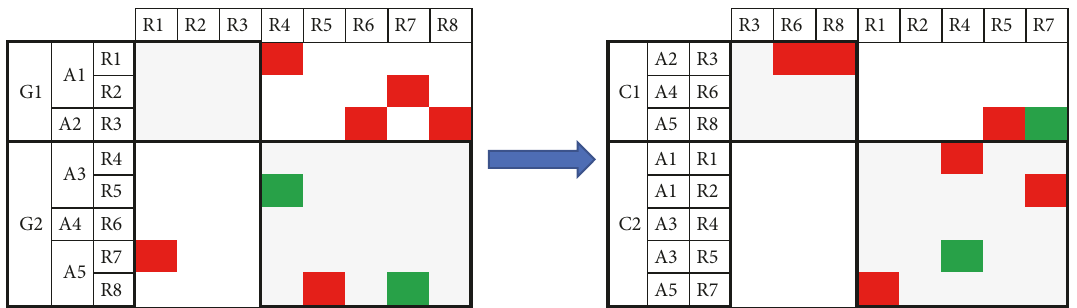
Figure 1: Illustration on a simple example of the difference between initial and clustered project organizations.